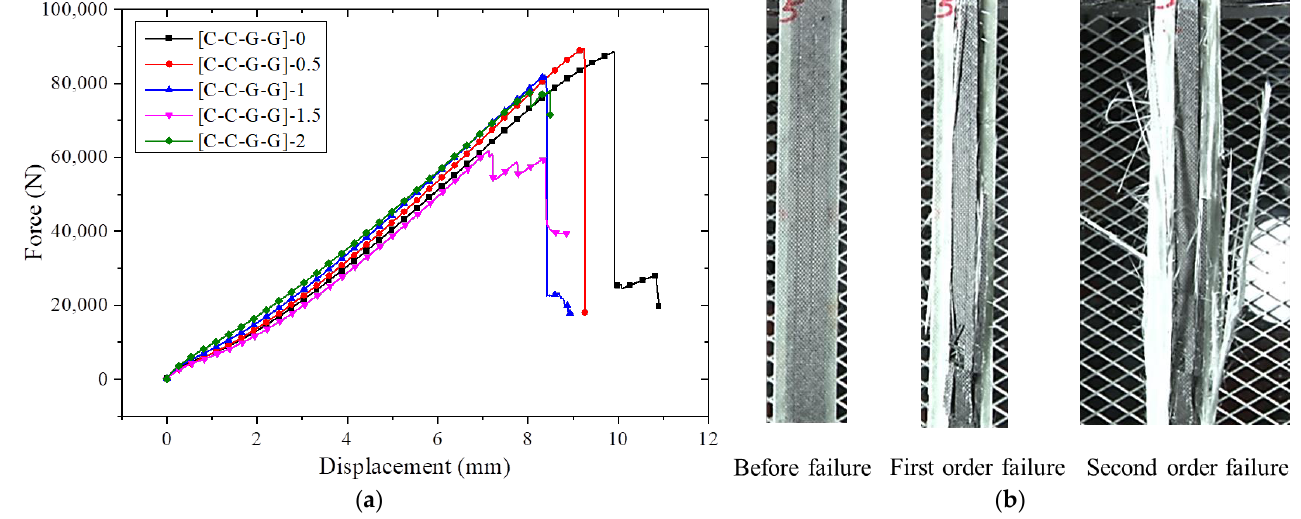
Figure 7. Tensile properties of intralayer hybrid composites with C:G = 1:1. ( a ) Tensile force–displacement curves; ( b ) tensile failure process.